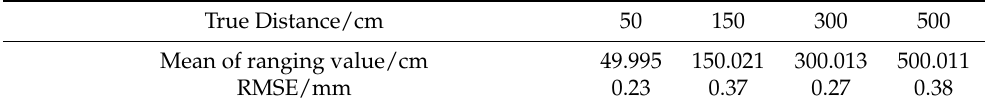
Table 1. RMSE( σ R ) results at different